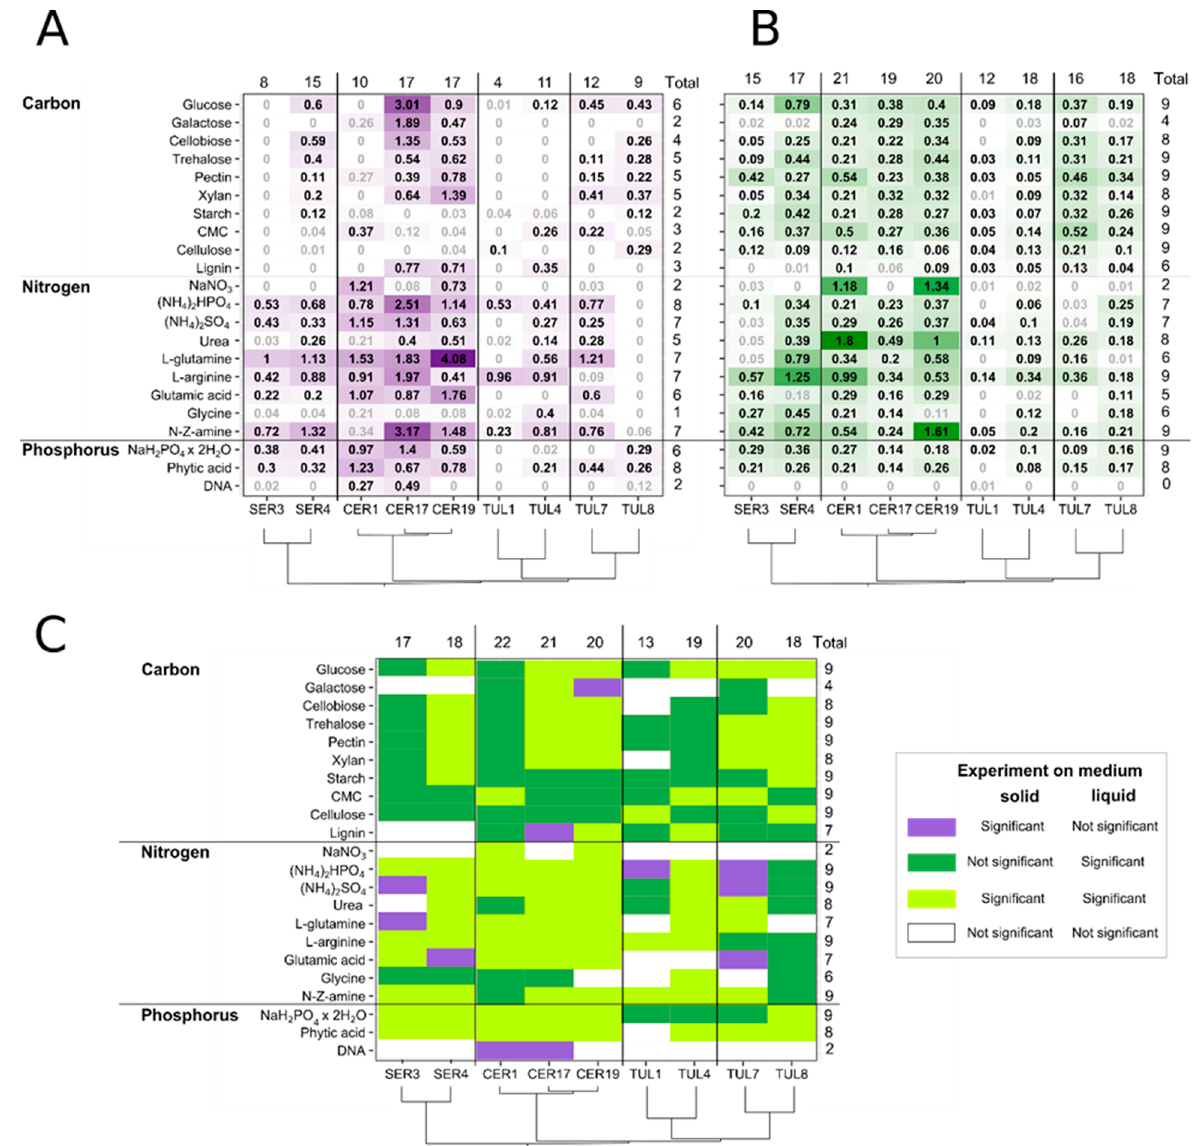
Figure 2. Fungal biomass production (in mg/day; mean value) of nine fungal isolates grown on C, N and P substrates in solid ( A ) or liquid media ( B ). The biomass production on a particular substrate was subtracted from the substrate-free control (values significant at p < 0.05 are denoted in bold). The colour shades indicate the amount of biomass increase. ( C ) Comparison of significant biomass increases between solid and liquid media. The phylogenetic tree based on ITS sequences shows genetic relatedness of the isolates (see Figure 1). The values on the margins of the chart represent the total numbers of treatments (on the top) or isolates (on the right) in which a significant biomass increase was induced at least in one medium. See Table S1 for details of each substrate.